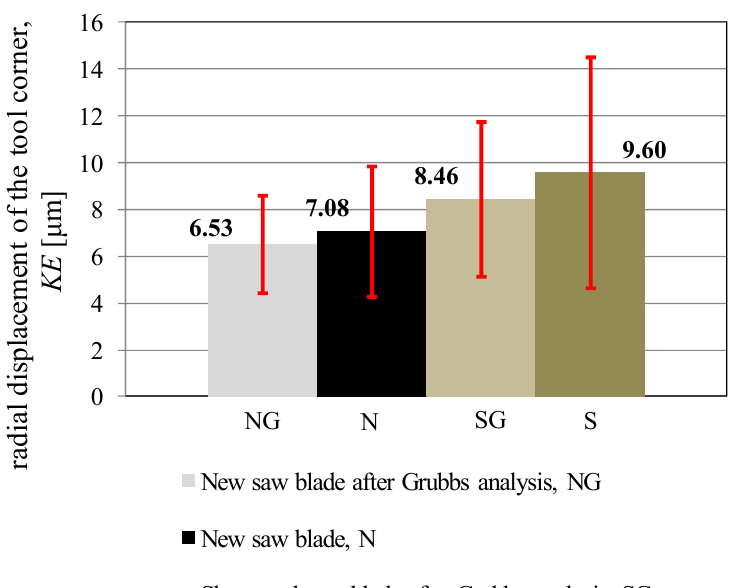
Figure 6. Mean values of the tool corner radial displacement KE with standard